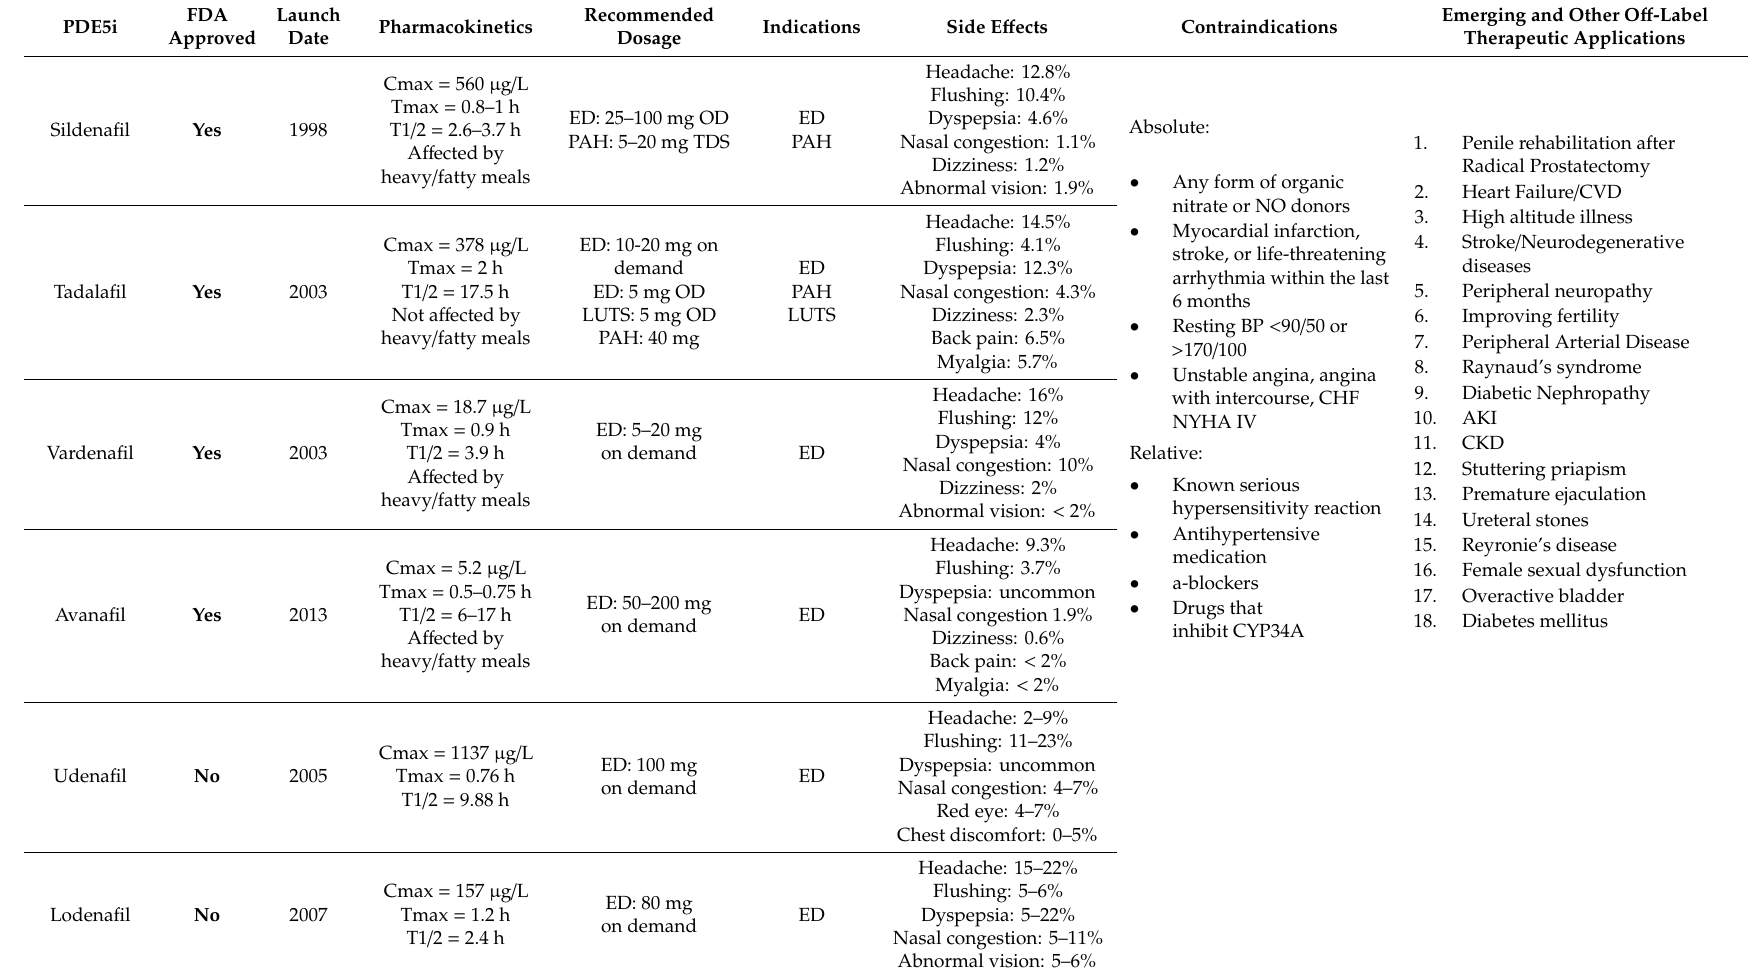
Table 7. Main characteristics of phosphodiesterase 5